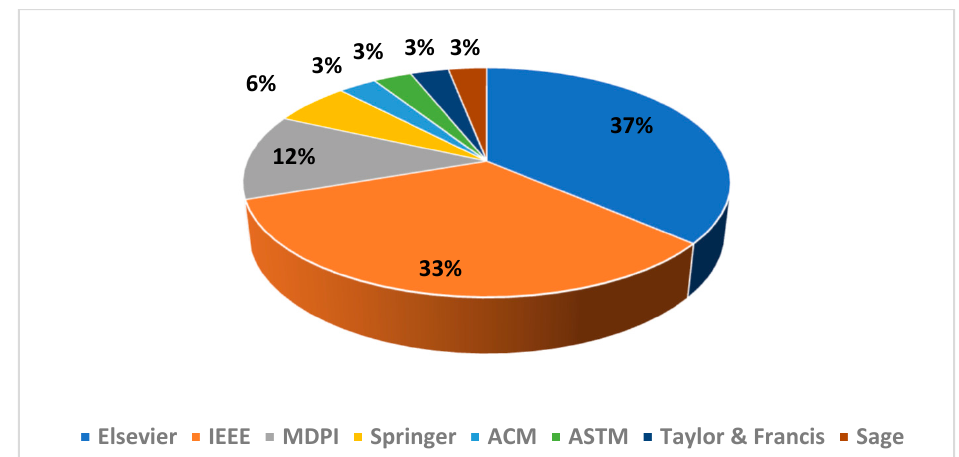
Figure 3. Distribution of PHM tasks for the selected articles.